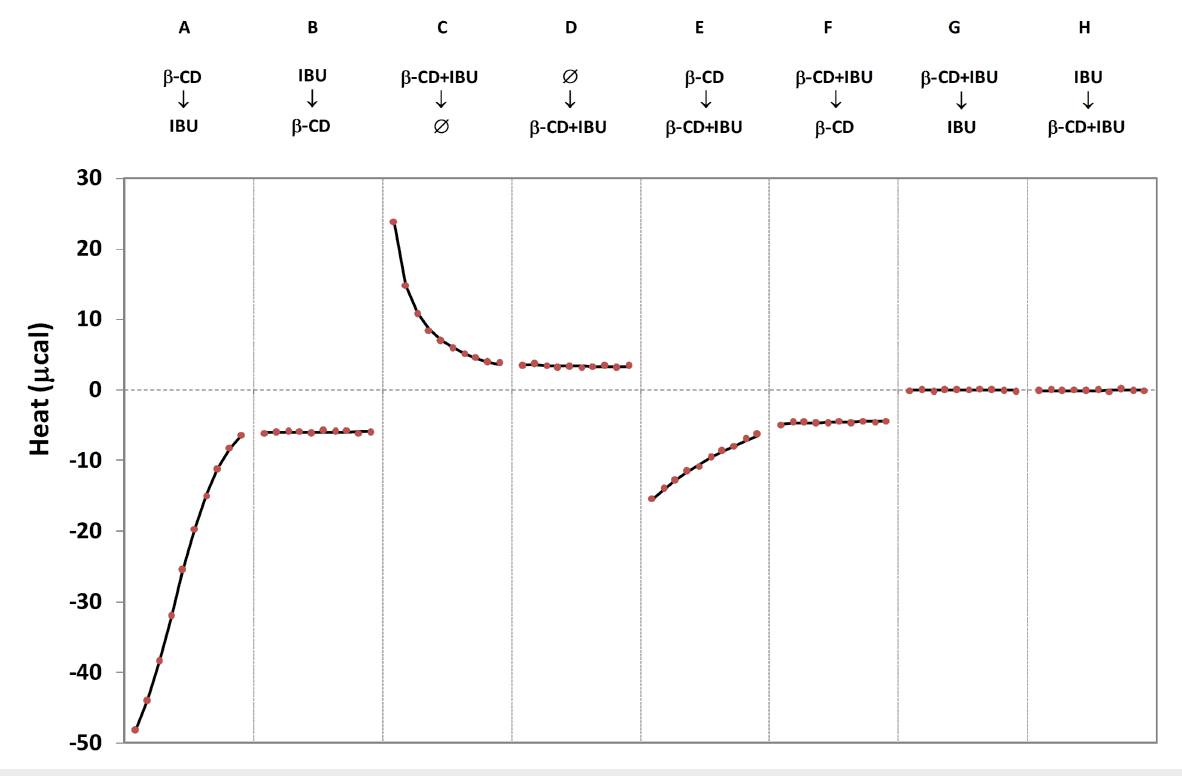
Figure 1: Non-competitive ITC isotherms for the β -CD-IBU complex at 298 K. Each protocol (from A to H) is defined by the respective content of syringe (top) and cell (bottom). Ø indicates the buffer solution. Lines and dots correspond to theoretical and experimental data, respectively. The x-axis corresponds to the injection number (10 injections per